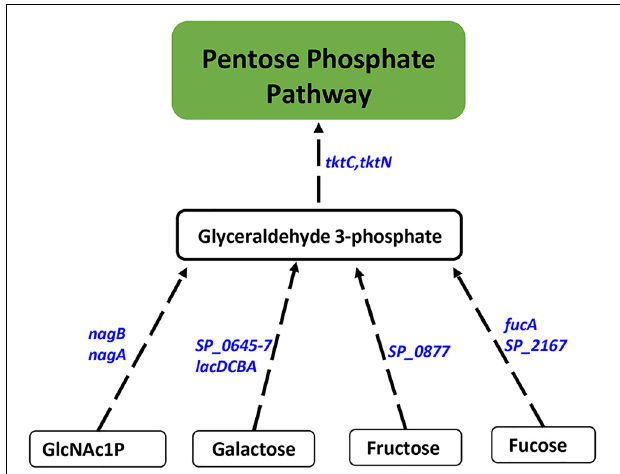
FIGURE 3 | Impaired polyamine synthesis results in increased carbon flow through the PPP. RNA-Seq-based transcriptome analysis of S. pneumoniae TIGR4 that harbors a gene deletion in a putative lysine decarboxylase identified significant upregulation of genes (italicized, blue) in carbohydrate metabolism that indicate increased G3P, an intermediate of glycolysis, and its utilization in PPP. Enzymatic reactions are shown as black arrows and multi-step reactions are represented by a broken arrow. Increased expression of genes in metabolic pathways catalyzing the conversion of galactose ( SP_0645-7 , lacDCBA ), fructose ( SP_0877 ), fucose ( fucA , SP_2167 ), and GlcNAc1P ( nagA , nagB ) to G3P with concomitant higher expression of transketolase C and N subunits ( tktC , tktN ) supports the increased metabolic flux through